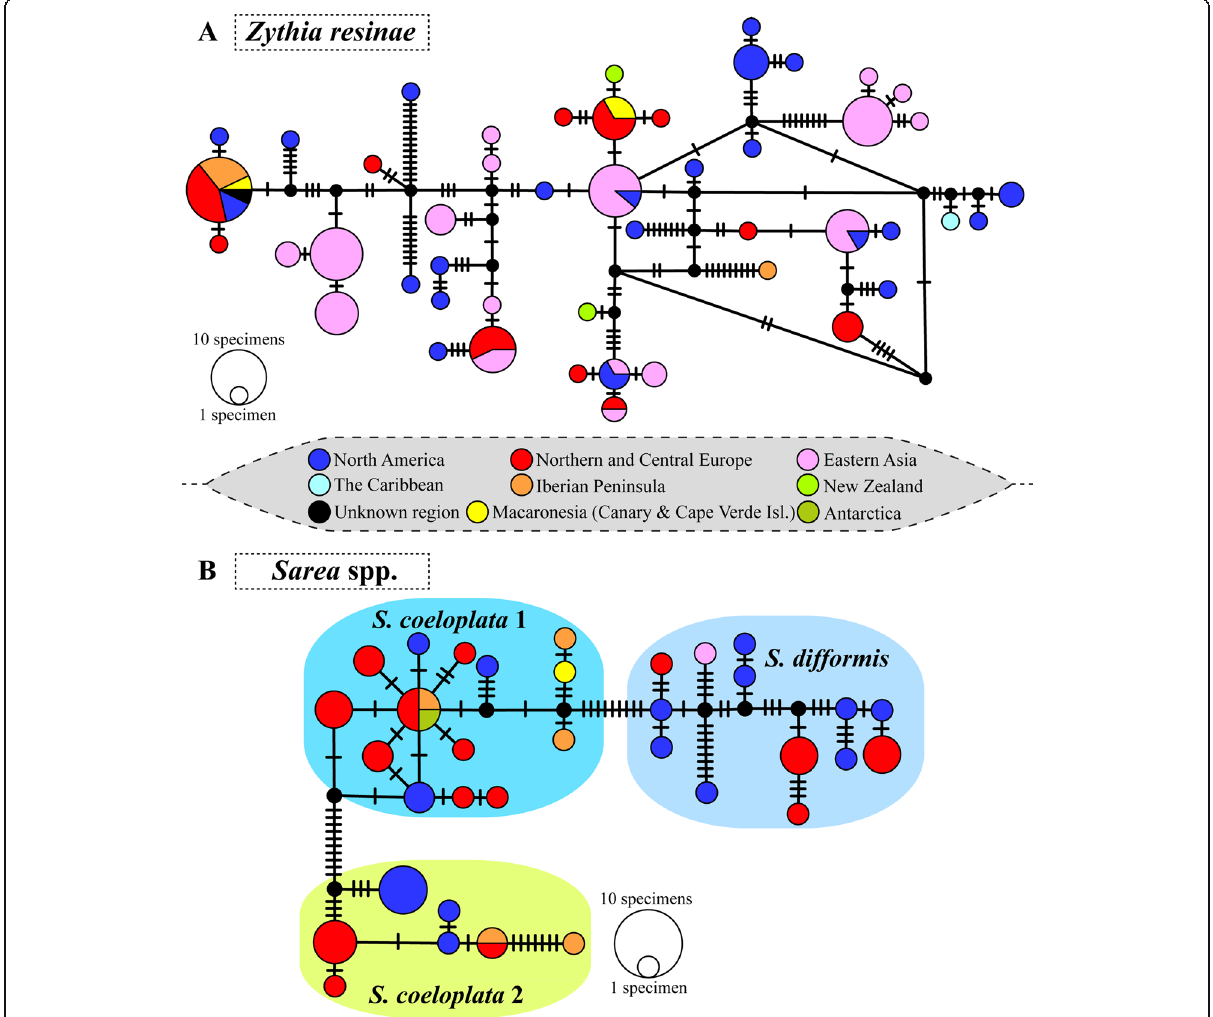
Fig. 5 Statistical parsimony networks for Zythia resinae and Sarea spp. haplotypes. a Zythia resinae . b Sarea spp. Haplotypes were coloured according to the geographic origin of specimens ( a legend is provided for reference). In b , a coloured box is used to delimitate each species within Sarea . The sizes of the circles in the networks are proportional to the numbers of individuals bearing the haplotype; black-filled smaller circles indicate missing haplotypes. Mutations are shown as hatch